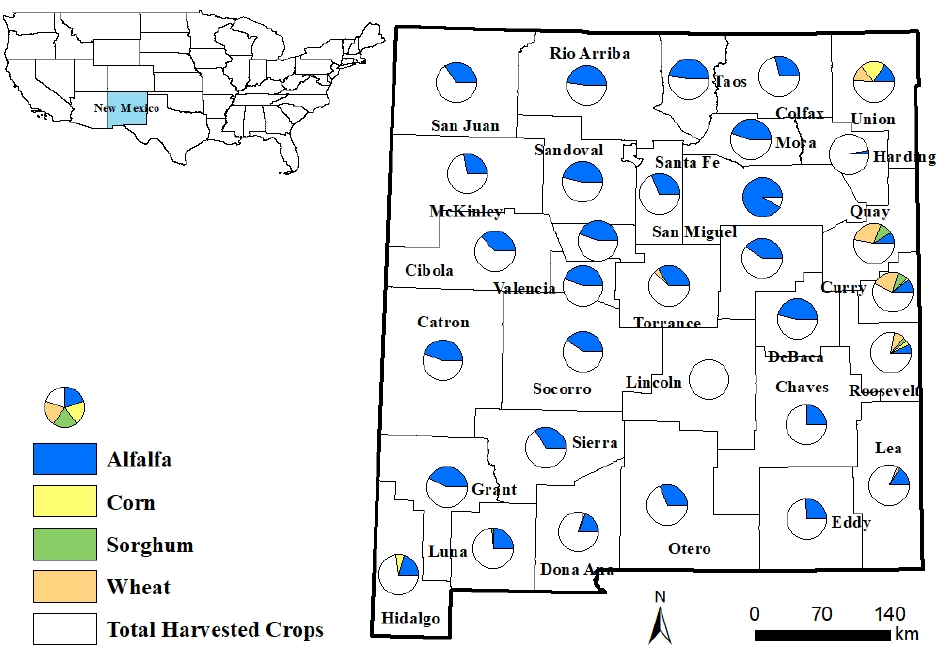
Figure 1. The map of New Mexico counties in the United States, including the share of harvested areas in acres for sorghum, wheat, alfalfa, and corn within the total harvested cropland areas in 2017 [54].